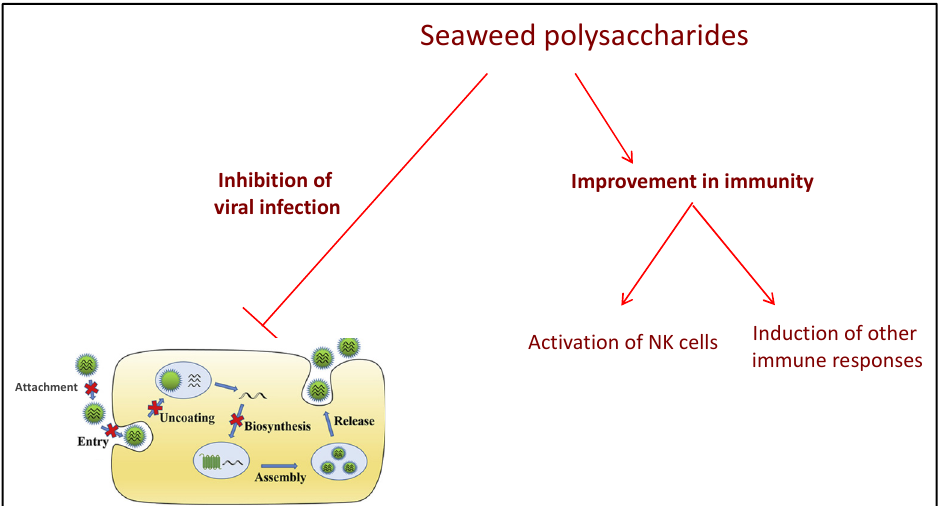
Figure 5. Mechanisms of anti-viral inhibition by seaweed polysaccharides. Seaweed polysaccharides display anti-viral activity against a range of viruses by interfering with different stages of viral attachment and replication as well as by improving host immunity (redesigned from [95]).